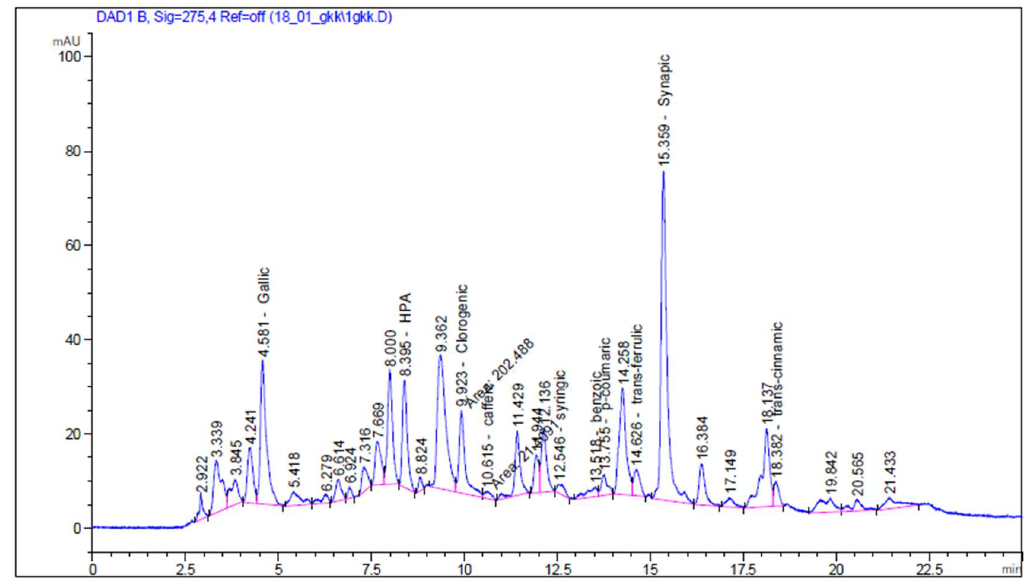
Fig. 4. Chromatogram of hydroxycinnamic acids of red oak leaves and